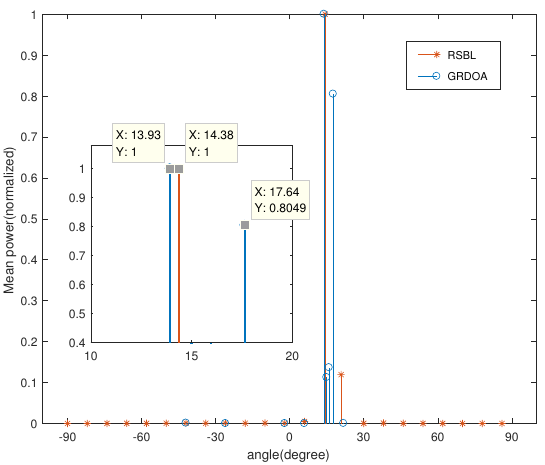
Figure 5. The spatial spectrum of GRDOA and RSBL. Sources are from 14 ◦ and 17 ◦ with SNR = 10